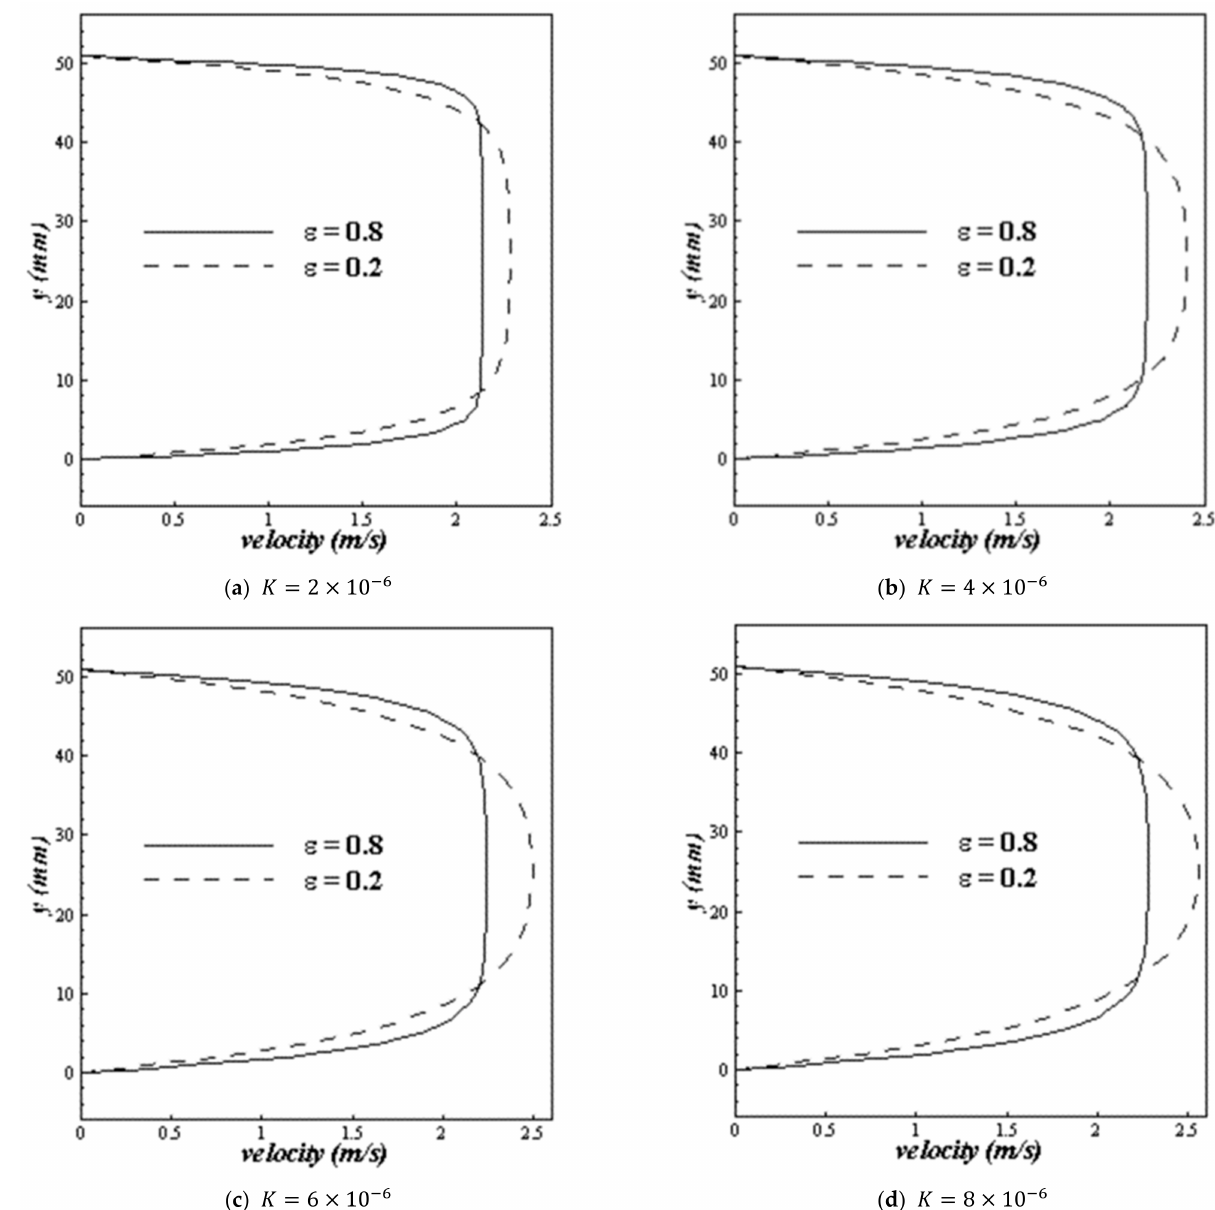
Figure 9. The variation in velocity profiles for the different values of permeability at the location of 500 mm in the length of the collector for the high, 0.8, and low, 0.2, porosity coefficients, with u in = 2